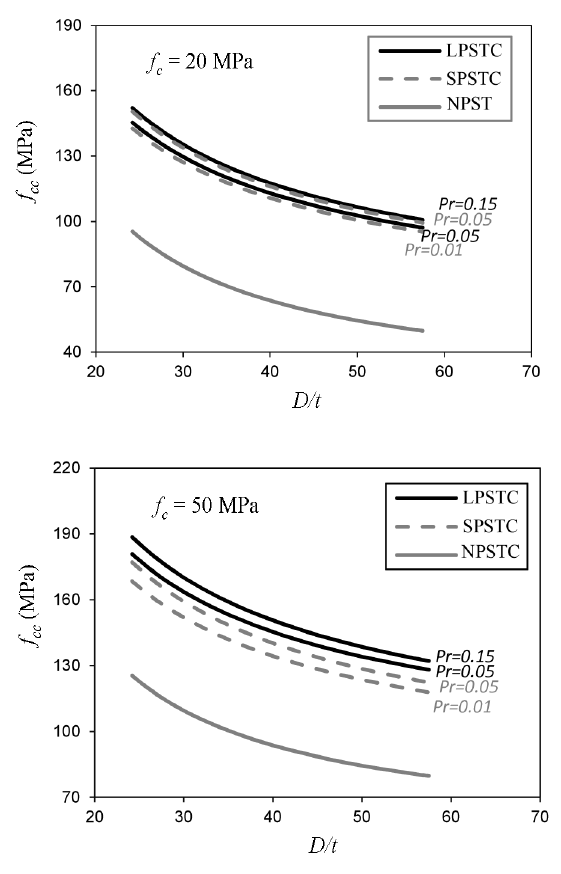
Fig. 7. Relationship of compressive strength of confined f ) versus tube outer diameter to wall thickness concrete ( cc ratio